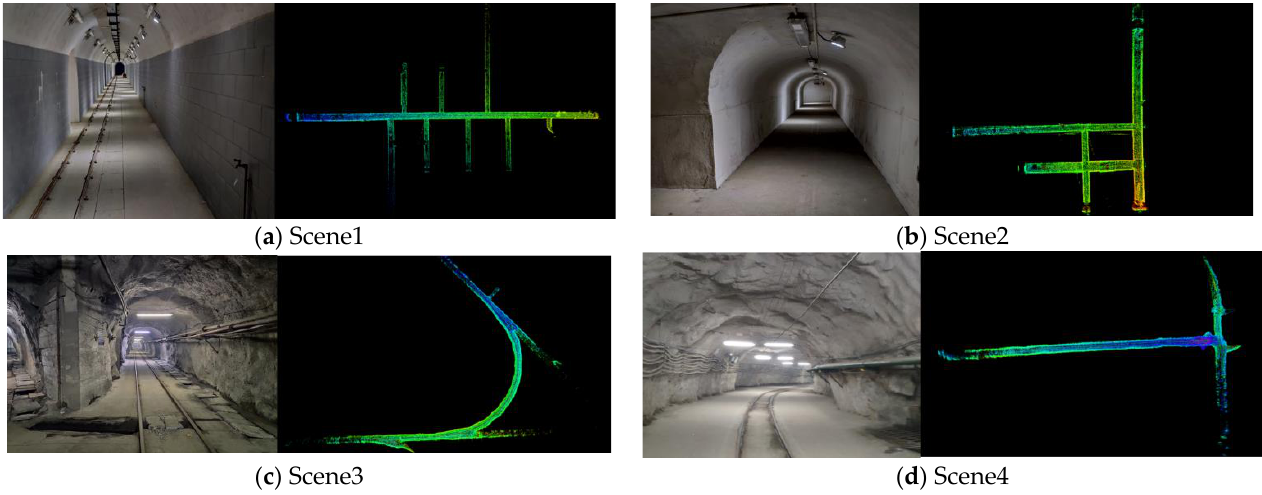
Figure 12. Four underground roadway scene and maps.